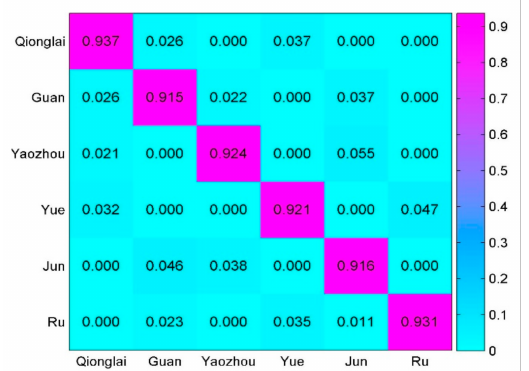
Figure 12. Classification performance of different kilns in confusion matrix. The rows and columns of the confusion matrix represent the real category and the predicted category, respectively. Accuracy is calculated as the number of samples correctly predicted divided by the total number of samples.